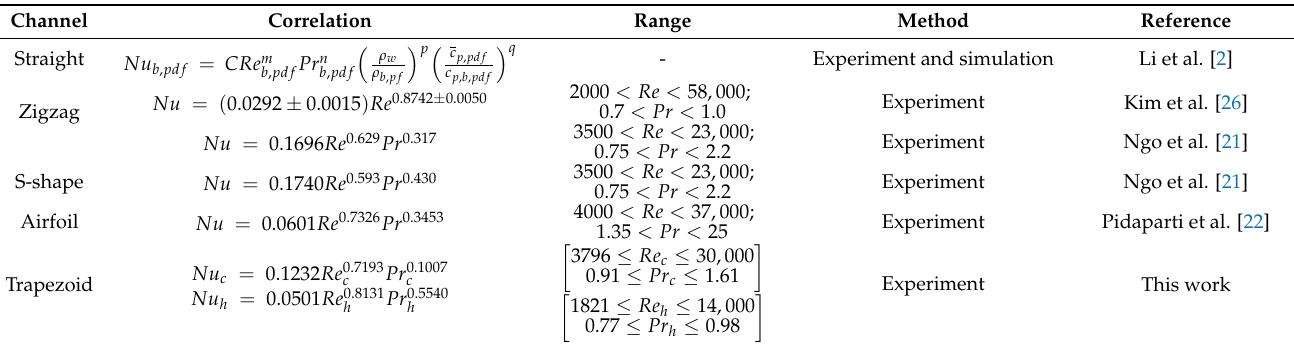
Table 7. Comparison of the heat transfer